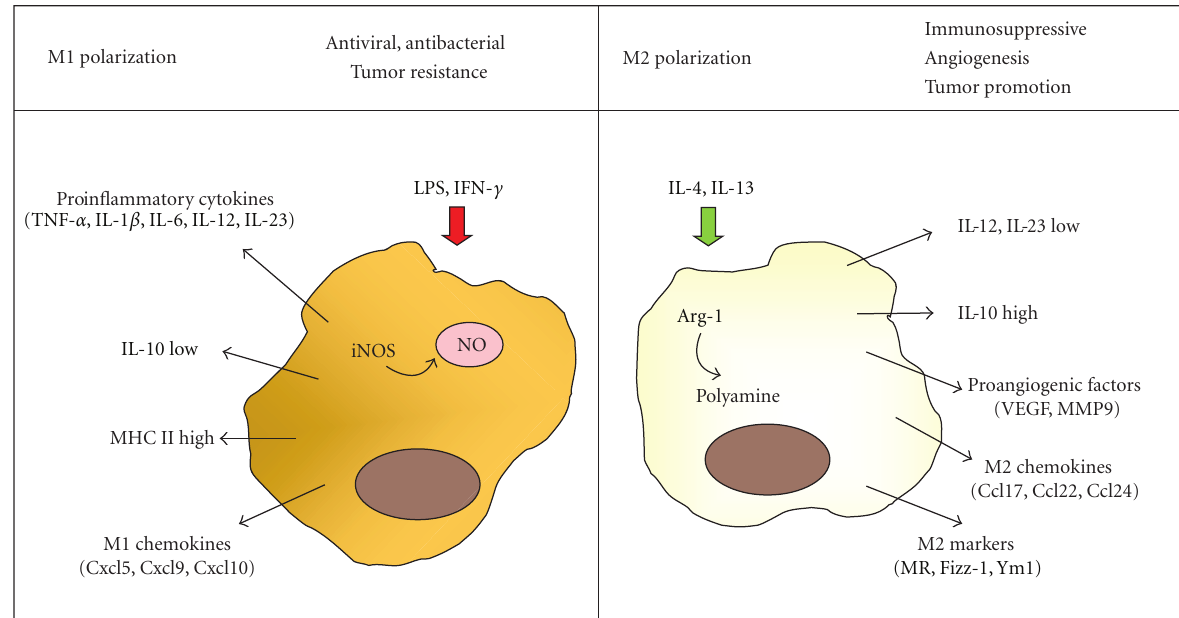
Figure 1: Simplified scheme for M1 and M2 activation of macrophages. M1 macrophages are induced by LPS or IFN- γ secreting high levels of classical proinflammatory cytokines such as TNF- α , IL-1, IL-6, IL-12, or IL-23, chemokines (e.g., Cxcl9, Cxcl10, and Cxcl5) and increasing their concentrations of NO. In addition, they express high levels of MHC I. IL-4/IL-13 stimulation induces M2 macrophages that downregulate IL-12 and IL-23 expression, release Ccl17, Ccl22 and Ccl24 chemokines and proangiogenic factors, and show increased expression of IL-10. Additionally, they are characterized by expression of MR, Fizz-1, and